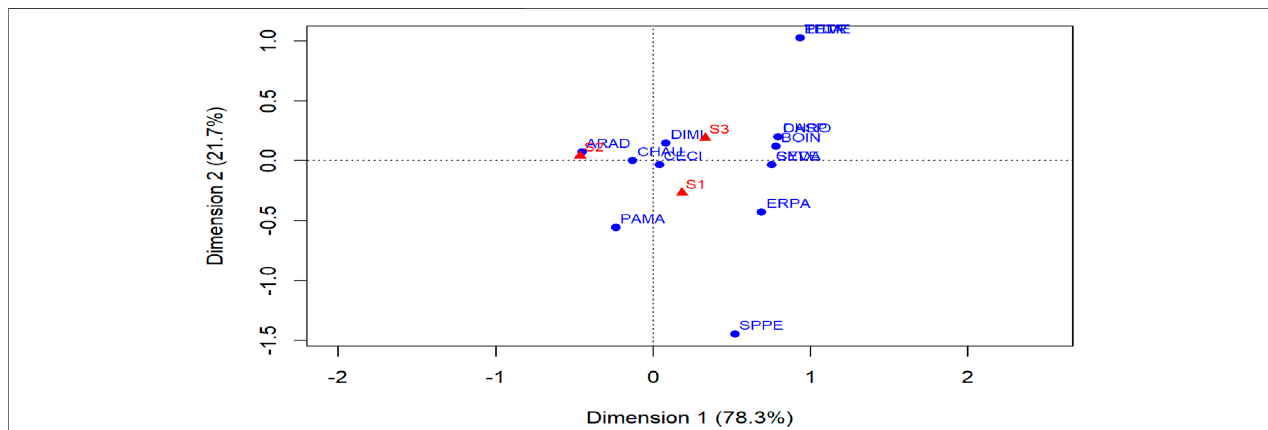
FIGURE4| CAordinationofgrassspeciesabundancebyseasoninthewoodythinnedBoranarangelandsofSouthernEthiopia. “ Dimension1 ” and “ Dimension2 ” represents ‘ Columns ’ and ‘ Rows, ’ respectively. Red diamond represents season. S1, season 1; S2, season 2, and S3, season 3. Blue dot means species. Species codes are: ARAD, Aristida adscensionis ; BOIN, Bothriochloa insculpta ; CECI = Cenchrus ciliaris ; CHRO, Chloris roxburghiana ; CHAU, Chrysopogon aucheri ; CYDA, Cynodondactylon ;DASP, Dactylocteniumspecies ;DIMI, Digitariamilanjiana ;ELJA, Eleusinejaegeri ;ERPA, Eragrostispapposa ;PAMA, Panicummaximum ;EME, Pennisetum mezianum ; SEVE, Setaria verticillata ; SPPE, Sporobolus pellucidus , and THTR, Themeda triandra .